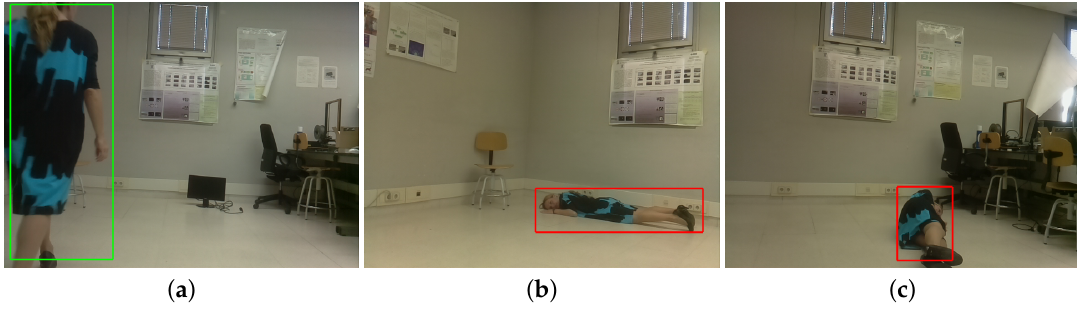
Figure 4. Aspect ratio. ( a ) Standing person AR i = 0.402. ( b ) Fallen person in horizontal-pose orientation position AR i = 3.810. ( c ) Fallen person in vertical-pose orientation position AR i = 0.751.